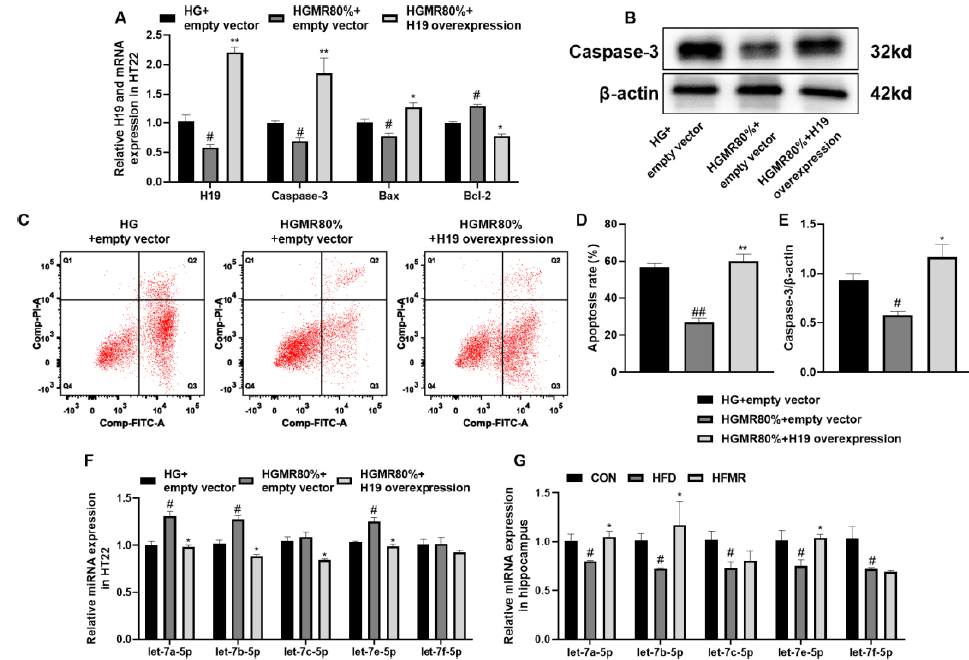
Figure 8. MR inhibited HT22 cell apoptosis likely through H19/let-7/caspase-3 pathway. ( A ) Relative H19 and mRNA expression in HT22. ( B ) Caspase-3 western blotting bands. ( C , D ) The apoptosis of HT22 cells. ( E ) Relative protein expression of caspase-3 in HT22. ( F ) Relative miRNA expression in HT22. ( G ) Relative miRNA expression in hippocampus. All data are shown as the mean ± SEM. # p < 0.05, ## p < 0.01 (versus CON or HG + empty vector); * p < 0.05, ** p < 0.01 (versus HFD or HGMR80% + empty vector).